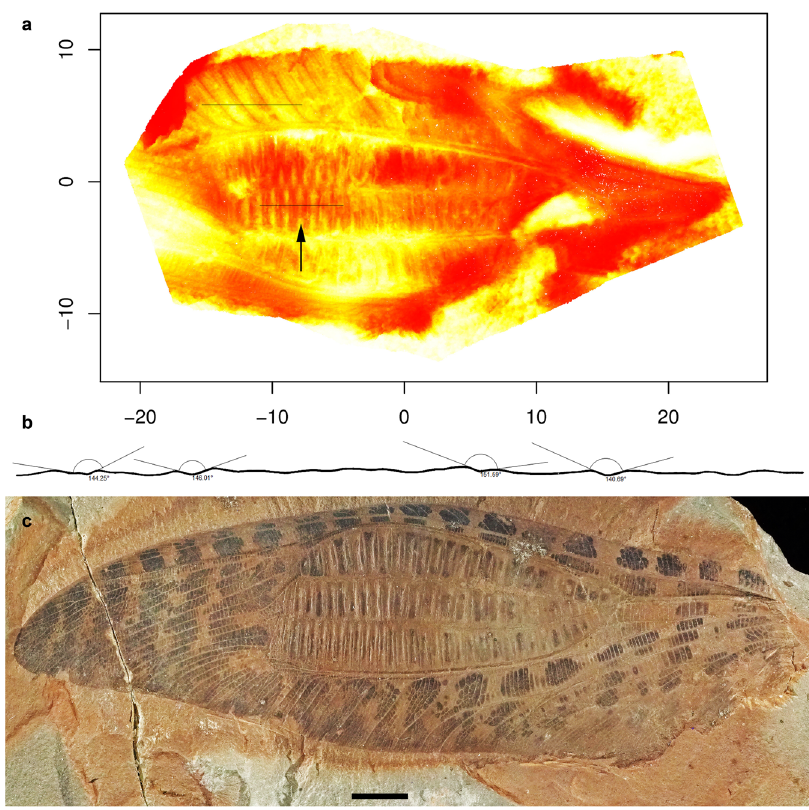
Fig. 4 Clatrotitan andersoni McKeown 12 , likely producing fl ashes of light. Specimen NHM In. 37341. a False colors showing the relative reliefs of surfaces; line above: unspecialized zone; line below and arrow: specialized zone; deep zones in red, higher zones in yellow. b Virtual cross-section of specialized zone showing the angles between the different surfaces along line below. c AMF36274. Forewing. Scale bar: 10